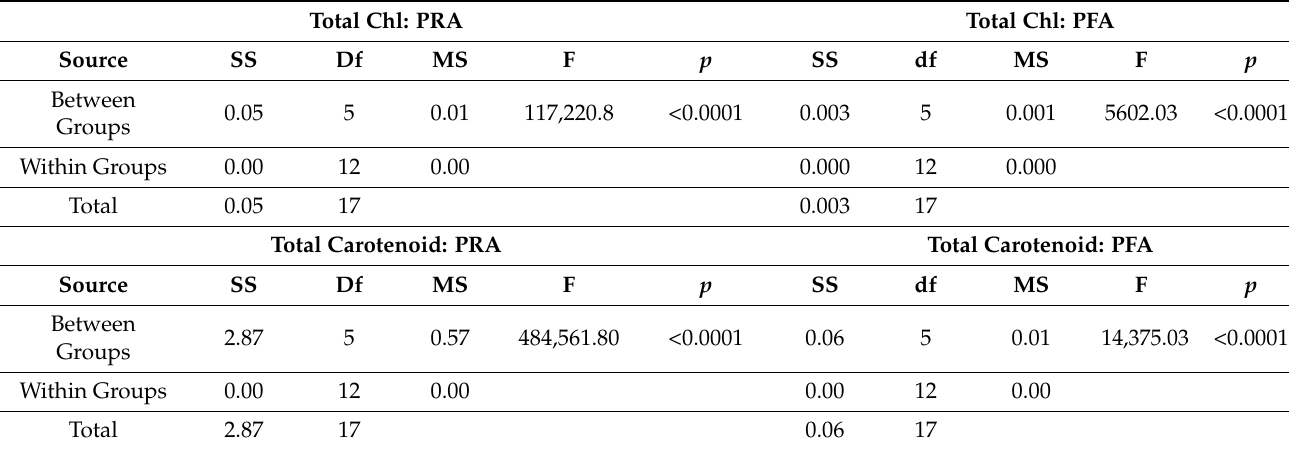
Table 9. ANOVA for pot foliar application (PFA) and pot root application (PRA) of ANE on the photosynthetic pigments.